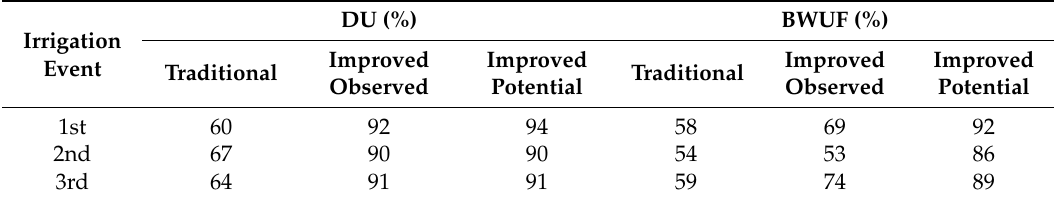
Table 5. DU and BWUF obtained from observations in traditional and precise levelled basins for various irrigation events and their potential values (from Miao et al.